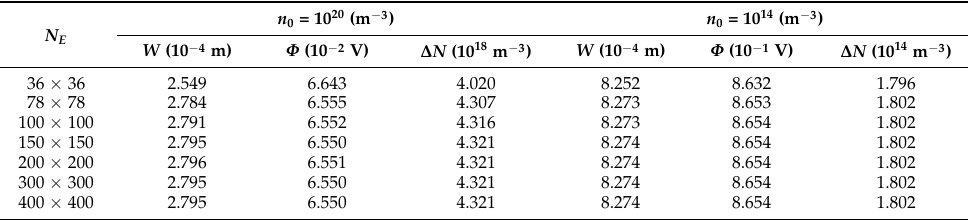
For the central point ( l /2, d /2) of the plate, the absolute value of the deflection W versus the excitation frequency ω is plotted in Figure 2. Three peaks W occur because of the resonance and correspond to the first three order natural frequencies ω 1 , ω 2 , and ω 3 , with values 4.653 × 10 8 rad/s, 8.305 × 10 8 rad/s, and 11.265 × 10 8 rad/s, respectively.